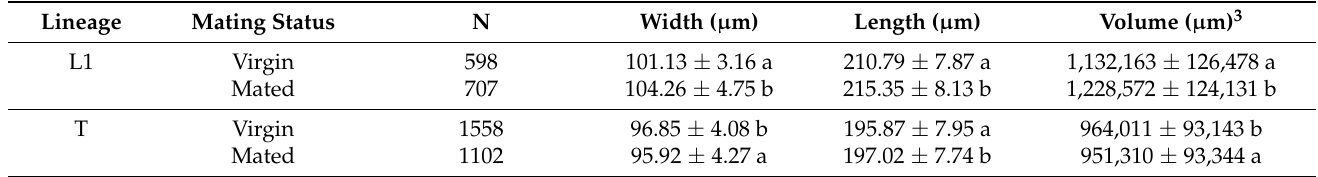
Table 4. Size of eggs produced by virgin and mated mothers of the L1 and T lineages throughout the lifespan.